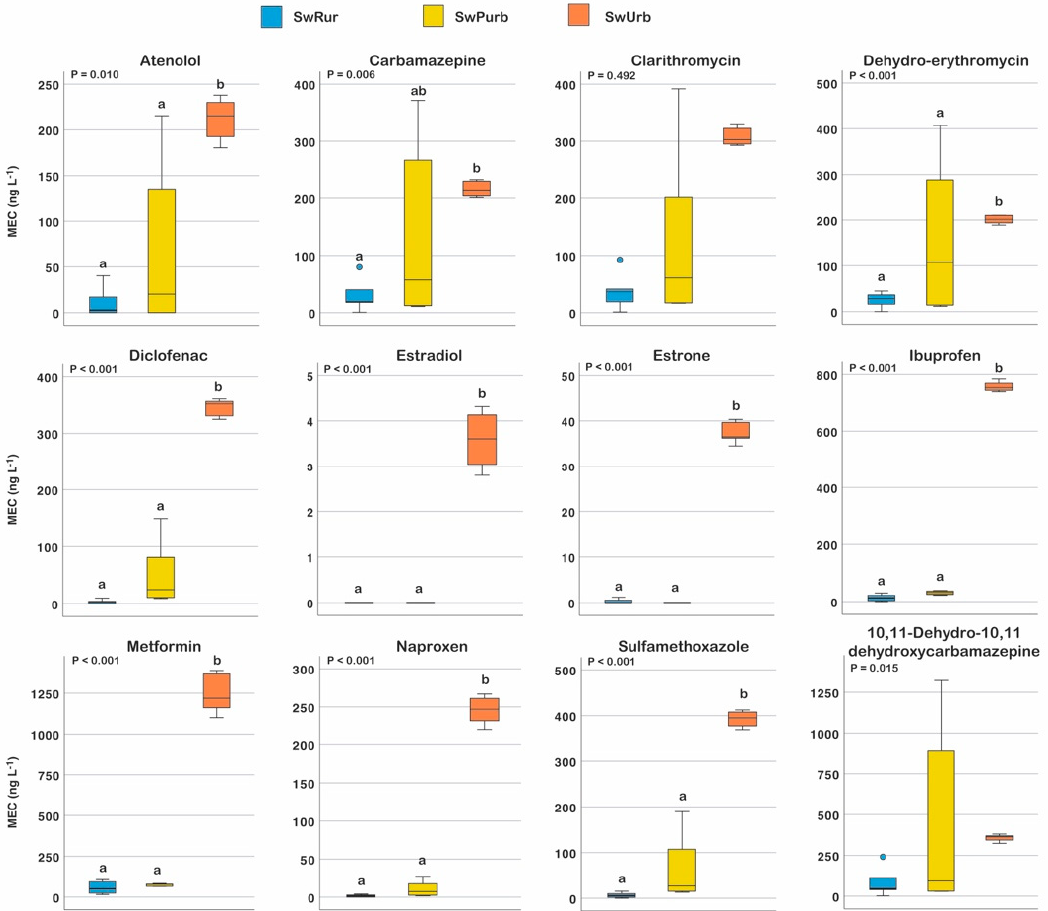
Figure 4. Box plot indicating measured environmental concentration (MEC) of selected pharmaceuticals (ng L − 1 ) in surface waters and effluent wastewater collected in March and September 2016 campaigns from the sampling points in a coastal area of Central Italy (SwRur: rural area; SwPurb: periurban area; SwUrb: urban area; EffWWTP: effluent of the wastewater treatment plant). The box indicates the 25th and 75th percentiles, the horizontal line indicates the median, and the whiskers indicate the lowest and the highest values. Different small letters represent significant differences among treatments (LSD test on estimated marginal means, P ≤ 0.05), applying a one-way ANCOVA. Dehydro-erythromycin and 10,11-dehydro-10,11-dehydroxycarbamazepine are metabolites of erythromycin and carbamazepine, respectively.